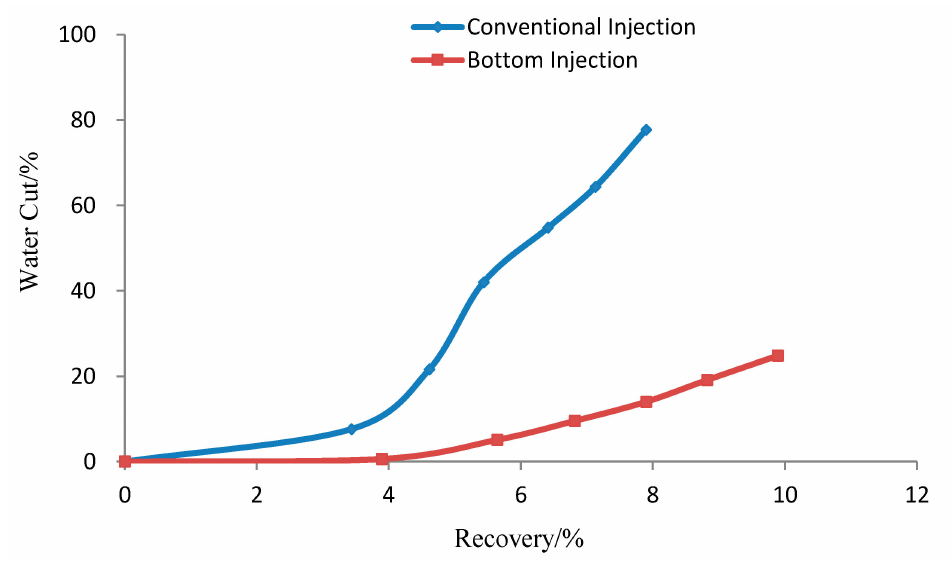
Figure 7. Comparison of conventional injection and bottom